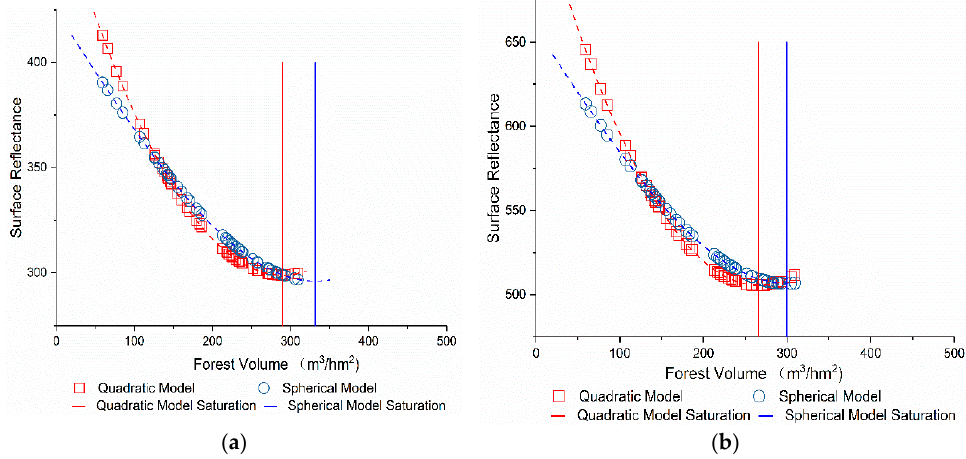
Figure 3. GSV saturation diagram based on different remote sensing features. ( a ) Band 3 from GF-1; ( b ) band 5 from Sentinel-2.